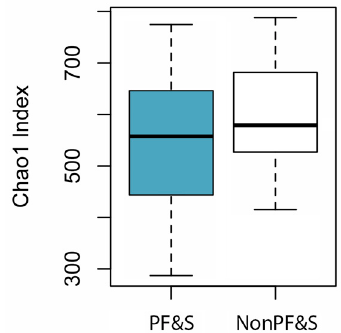
Figure 1. Chao1 index of gut microbial alpha diversity in participants with PF&S and in nonPF&S controls.